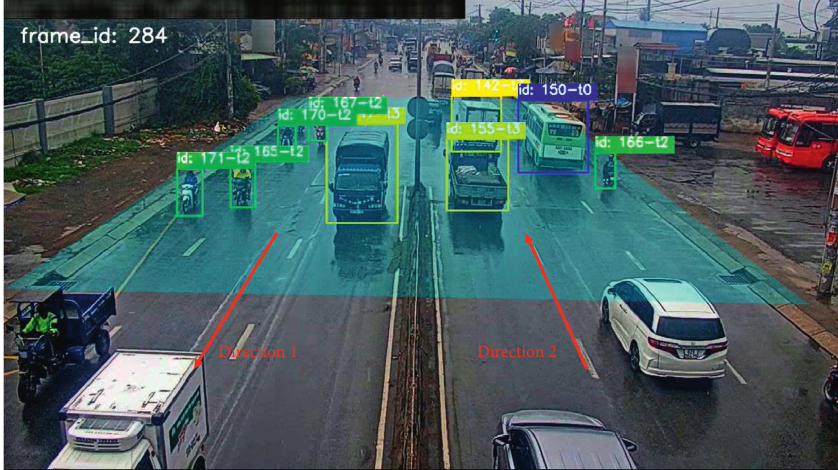
Figure 13: Tracking result running on board of Camera 06 belonging to the set of testing videos. Table 3: Evaluating experimental traffic counting result on Camera 06. Type of